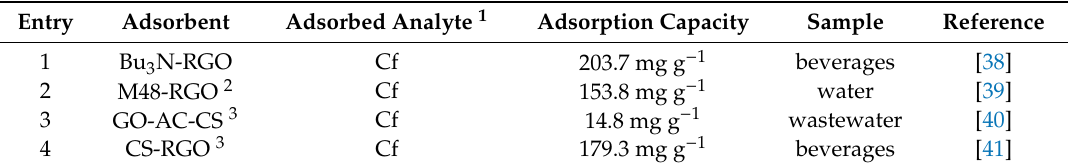
Table 1. Schematic overview on the use of GO and RGO as adsorbents for natural methylxanthynes extraction in real samples (see text).